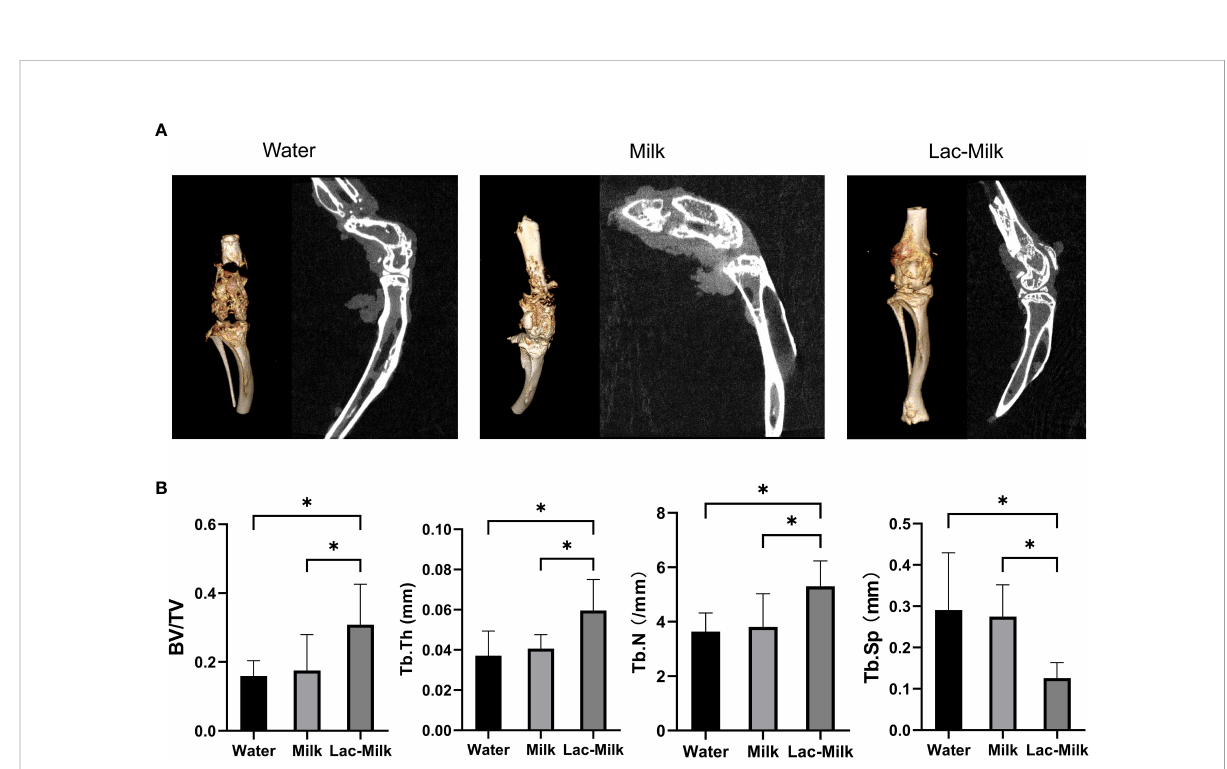
FIGURE 7 Micro-CTimages andmicroparametricanalysisof tibial trabeculaeat 28 dayspostoperatively. (A) RepresentativeMicro-CTimages. (B) Quantitativeanalysis ofbonetrabecularnumber(Tb. N), bonevalue/total value (BV/TV), bonetrabecularthickness(Tb. Th), andbonetrabecularspace(Tb.